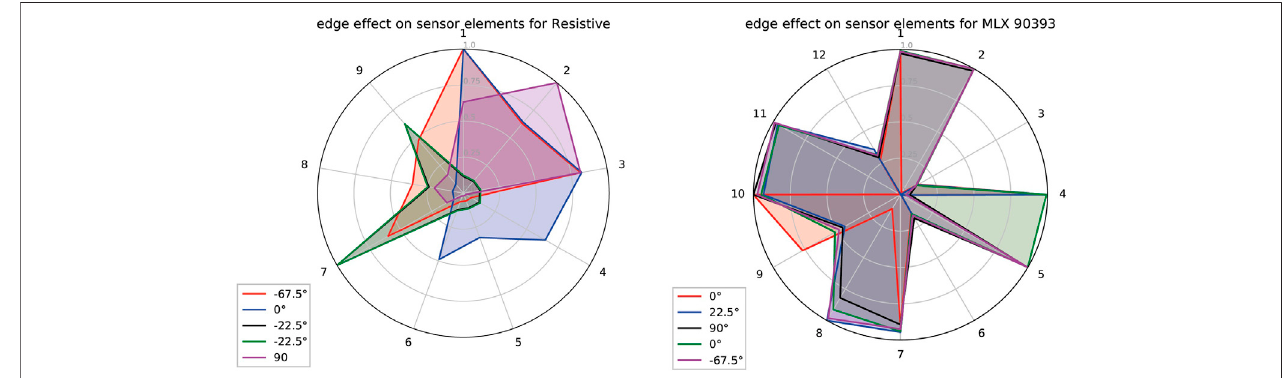
FIGURE 10 | Radar plot to show the edge effect on the different sensor taxels for the resistive and MLX90393 sensors.